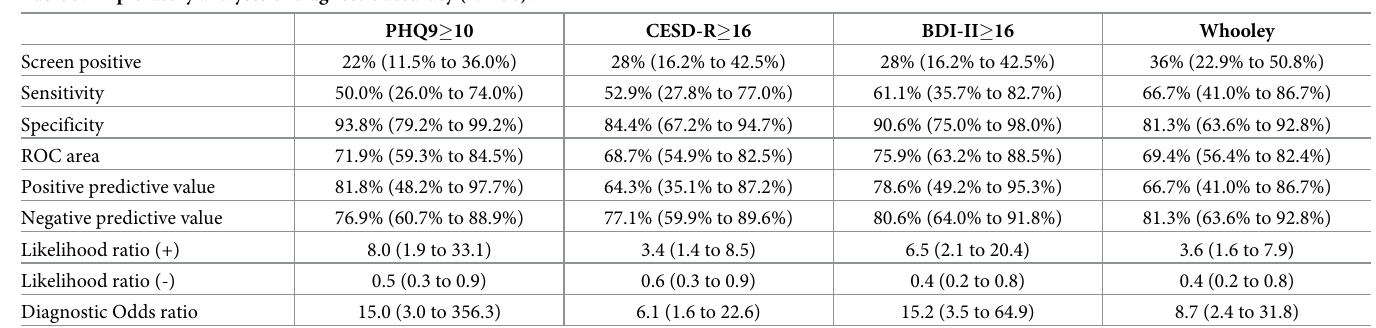
Table 5. Exploratory analyses of diagnostic accuracy (N = 50).